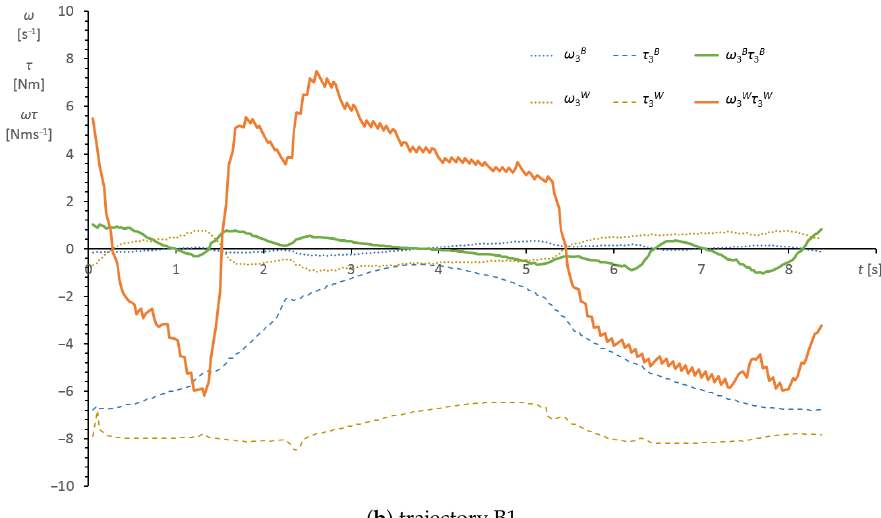
Figure 8. Comparison of the angular velocity ω 3 , torque τ 3 , and immediate power ω 3 τ 3 of the third joint during the whole trajectories A1 and B1 for the best ( B ) and worst ( W ) robot